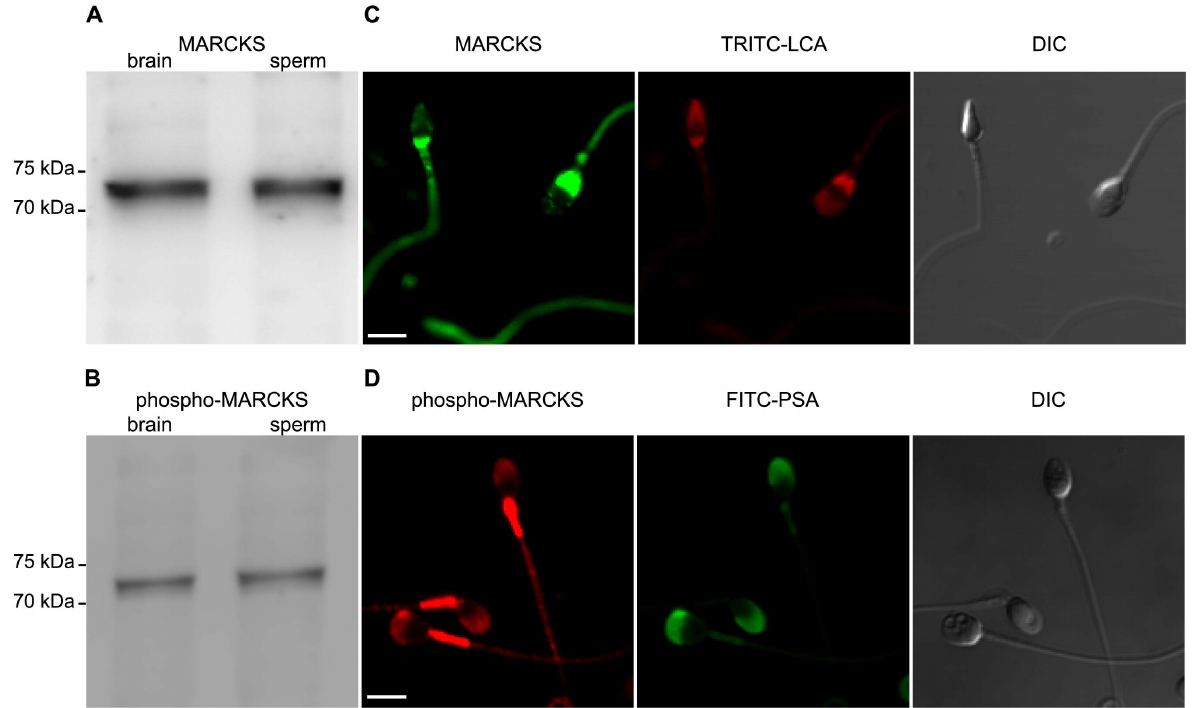
Figure 1. MARCKS is expressed in human sperm. ( A ) Proteins from whole sperm homogenates (sperm, 5 6 10 6 cells) were resolved in 10% SDS- PAGE gels and immunoblotted with the anti-MARCKS antibody raised against the N-terminus of MARCKS. Brain extracts (brain) was used as a positive control. ( B ) Identical to A but immunoblotted with the anti-phospho-MARCKS antibody. ( C ) Sperm were double-stained with the anti-MARCKS antibody followed by an anti-mouse-DyLight488-conjugated antibody and with tetramethylrhodamine isothiocyanate-labeled Lens culinaris agglutinin to stain acrosomes (TRITC-LCA). ( D ) Sperm were double-stained with the anti-phospho-MARCKS antibody followed by an anti-rabbit-Cy3 antibody and FITC-coupled Pisum sativum agglutinin to stain acrosomes (FITC-PSA). Shown are representative images from three different experiments. DIC, cells observed with differential interference contrast. Bars=5 m m